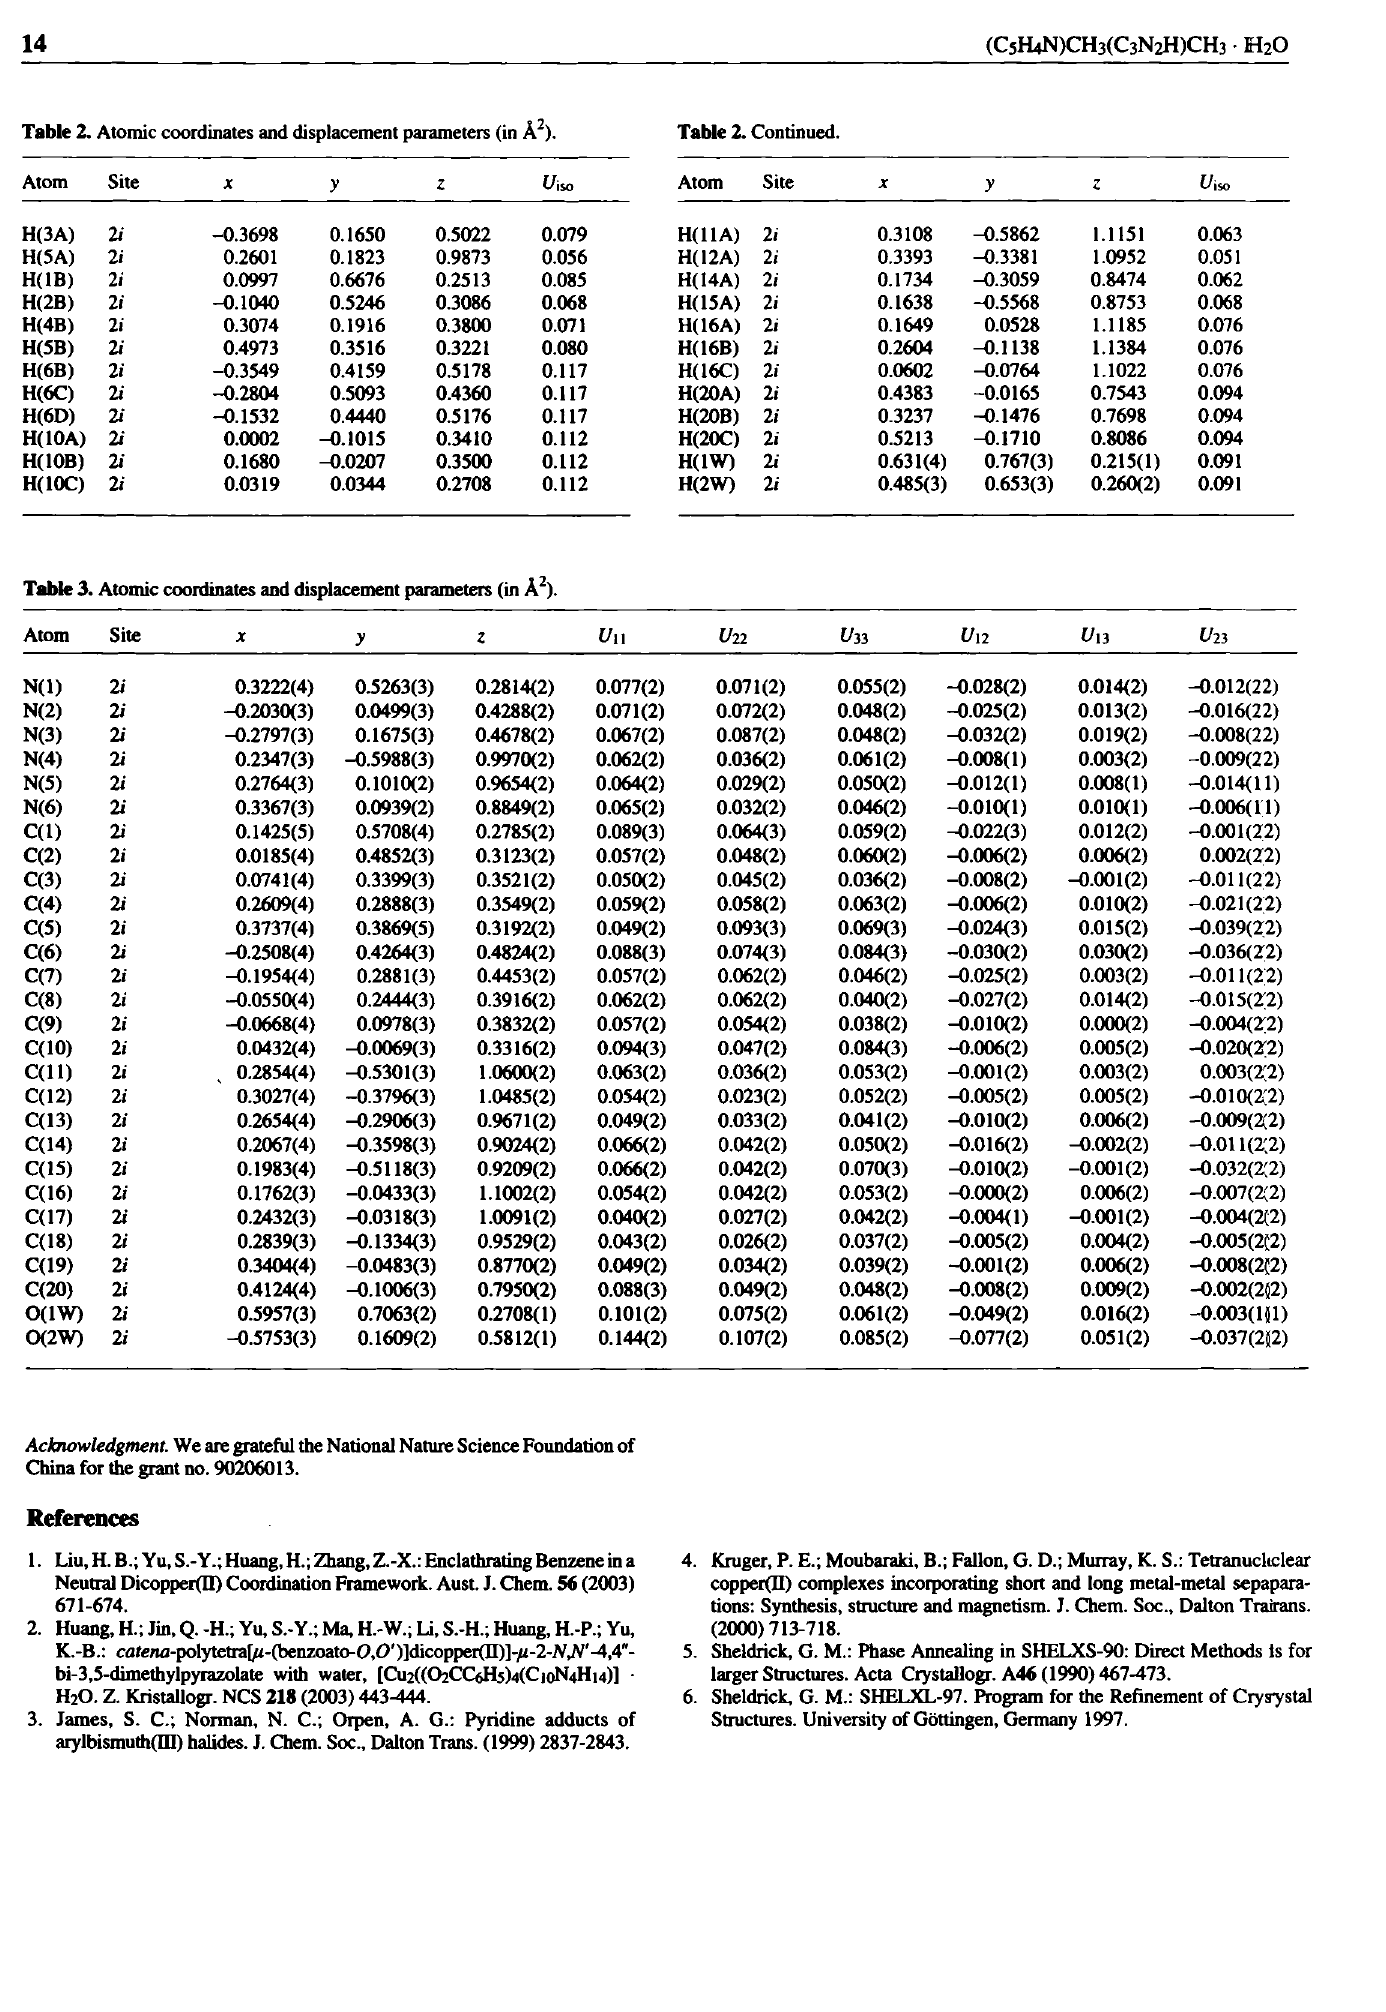
Table 2. Atomic coordinates and displacement parameters (in Â 2 ).